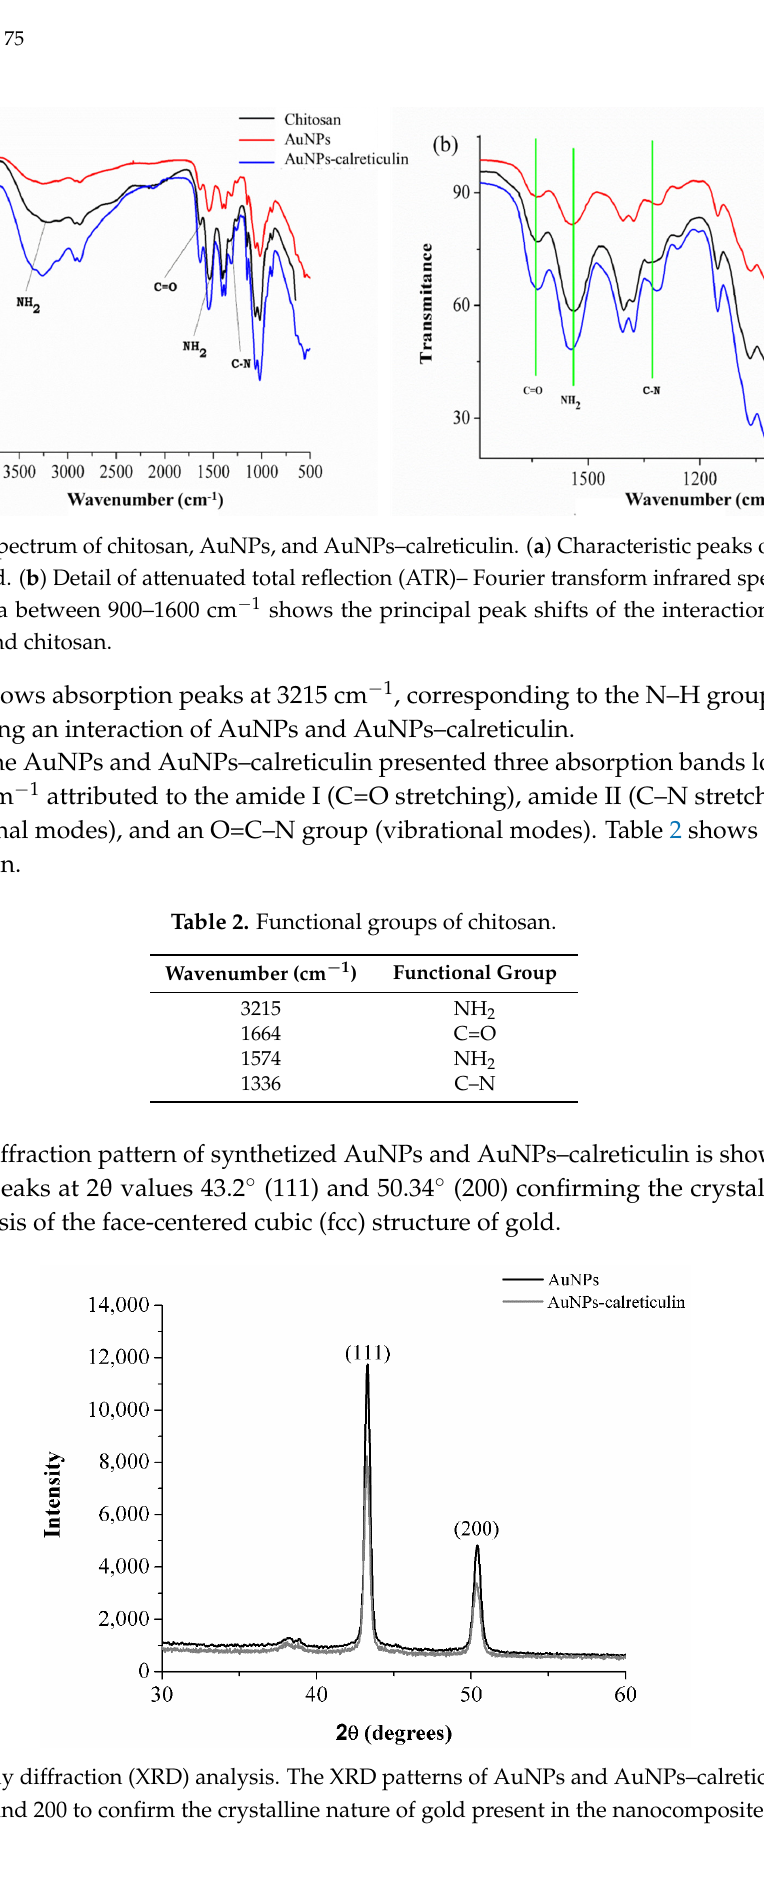
Figure 4. Release of calreticulin. Measurement of calreticulin release by ELISA test show an accumulative release of the protein present in the nanocomposite until 48 h. 3.4. Viability Assay for Cells Treated with AuNPs–Calreticulin Calreticulin did not affect the cell viability in HaCaT cells (Figure 5a), but in NIH/3T3 cells the viability decreased at 72 h with concentrations of 2.5, 5, 7, and 10 pg compared with cells treated with